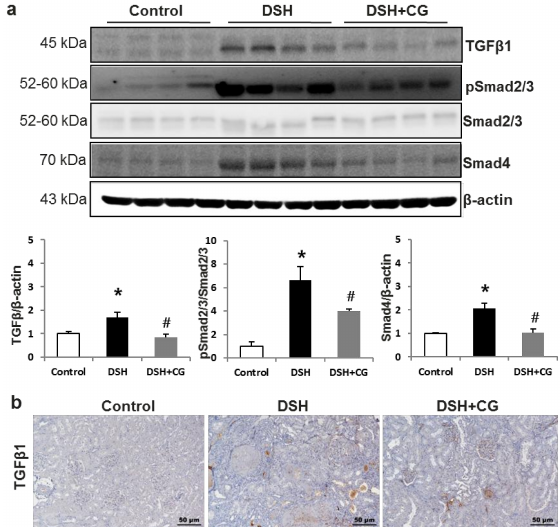
Figure 5. CG200745 suppresses the observed increase in TGF- β –Smad signaling observed in deoxycorticosterone acetate (DOCA)-salt hypertensive (DSH) rats. ( a ) Semiquantitative immunoblotting of TGF β 1 and Smad in the kidney. Densitometric analysis revealed that the protein expression of phospho-Smad 2/3 and Smad4was increased in DSH rats as compared to that in controls, which was counteracted by CG200745 treatment; * p < 0.05, when DHS or DSH + CG groups were compared to control group. # p < 0.05, when DSH + CG group was compared to DSH group. ( b ) Immunoperoxidase microscopy of TGF β 1 in the kidney cortex. Increased immunolabeling was observed in the DSH group, which was counteracted by CG200745 treatment. Magnification: 100 ×